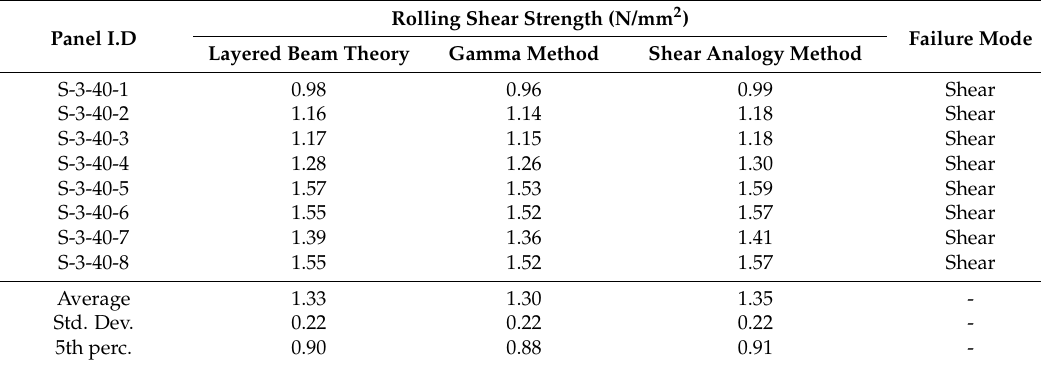
Table 7. Shear/Rolling shear test results for three-layer S-3-40 configuration.